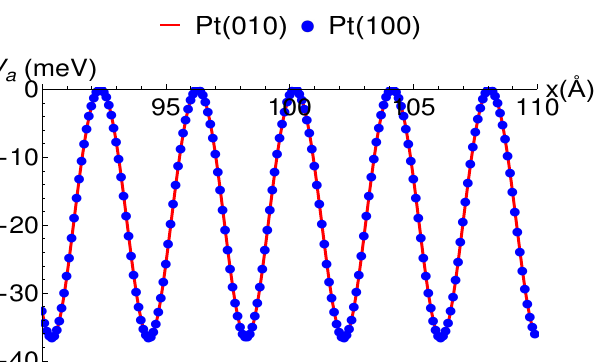
Figure 3. Projections of the interaction potential V a along the directions (100) and (010) of the surface in the interval x ∈ [ 90,110 ] Å. The projection on the (010) direction is represented by a red curve and the projection on (100) has been represented by blue